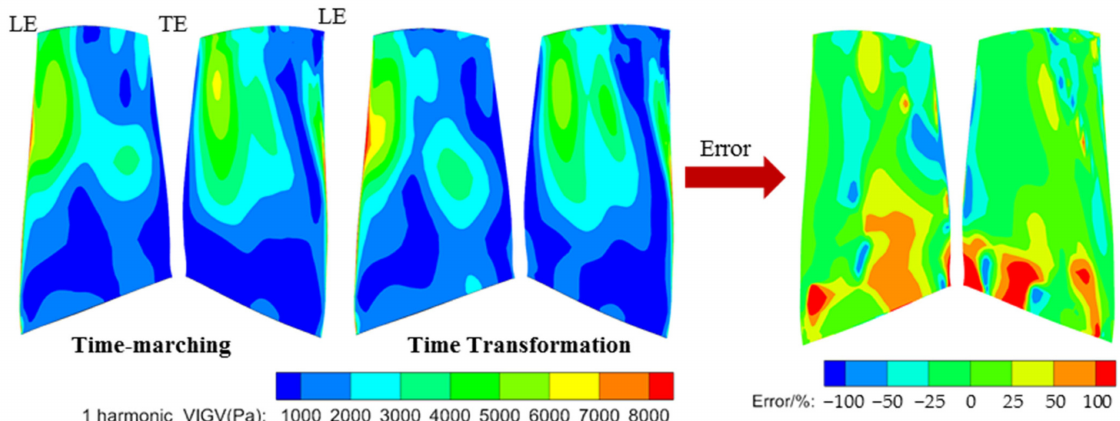
Figure 16. Harmonic pressure amplitude distribution of rotor blade, error = ( P TT − P TM ) / P TM